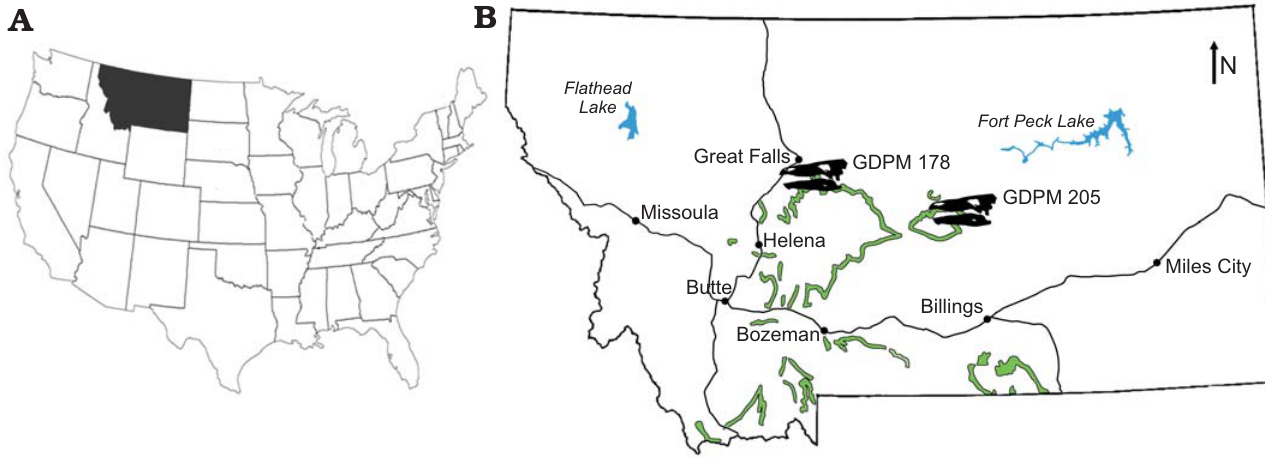
Fig. 1. A . Map of the USA with indicated the state of Montana, were the stegosaur specimens GPDM 178 and GPDM 205 were found. B . Map of Montana with the extent of the Morrison Formation in green, and the general locations of GPDM 178 and GPDM 205 indicated by the Stegosaurus skull silhouettes (modified from Maidment et al.